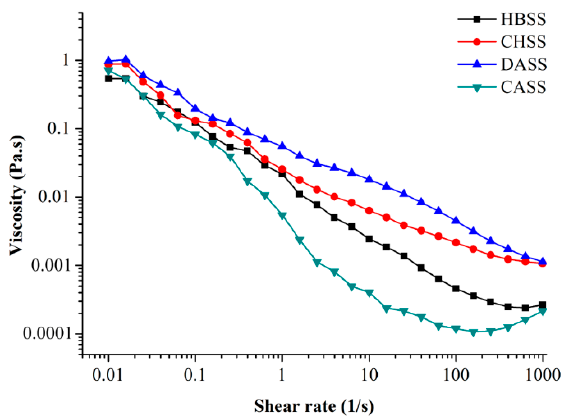
Figure 1. Effect of 1% mulberry polysaccharides (MLPs) on apparent viscosity with rising shear rate at 20 °C.